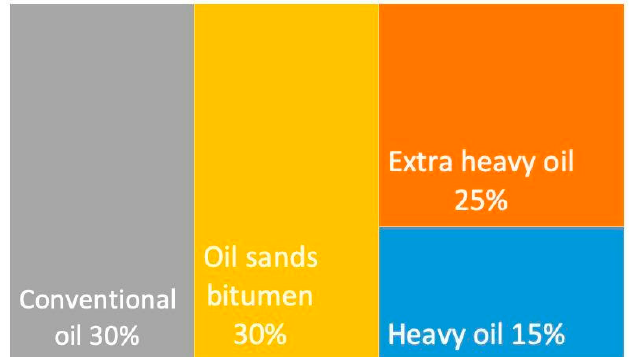
Figure 1. Percentage of world oil reserves showing conventional and unconventional resources [1].